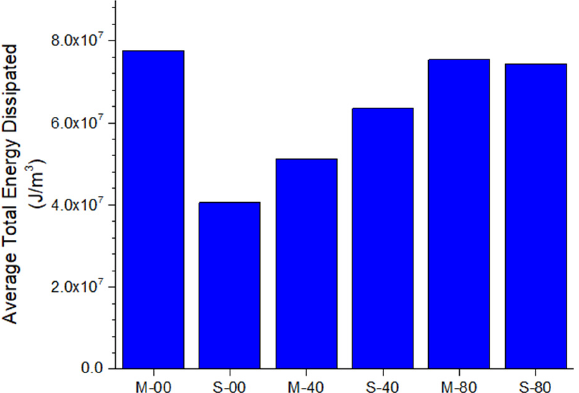
Buildings 2020 , 10 , x FOR PEER REVIEW Figure 10. Total energy dissipated of the concrete specimens tested. Figure 10. Total energy dissipated of the concrete specimens tested.